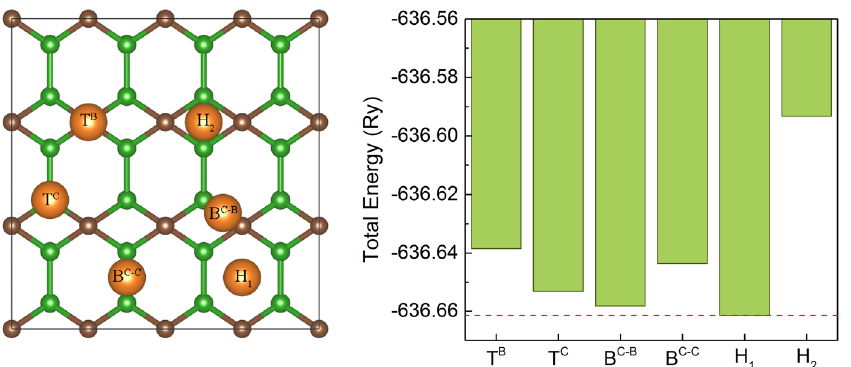
Figure 2. Possible adsorption sites on B 2 C surface for Mg atom (left panel) and comparison of total energy for a single Mg atom adsorbed at different sites on B 2 C monolayer (right panel). The red dotted line markers the values of the lowest